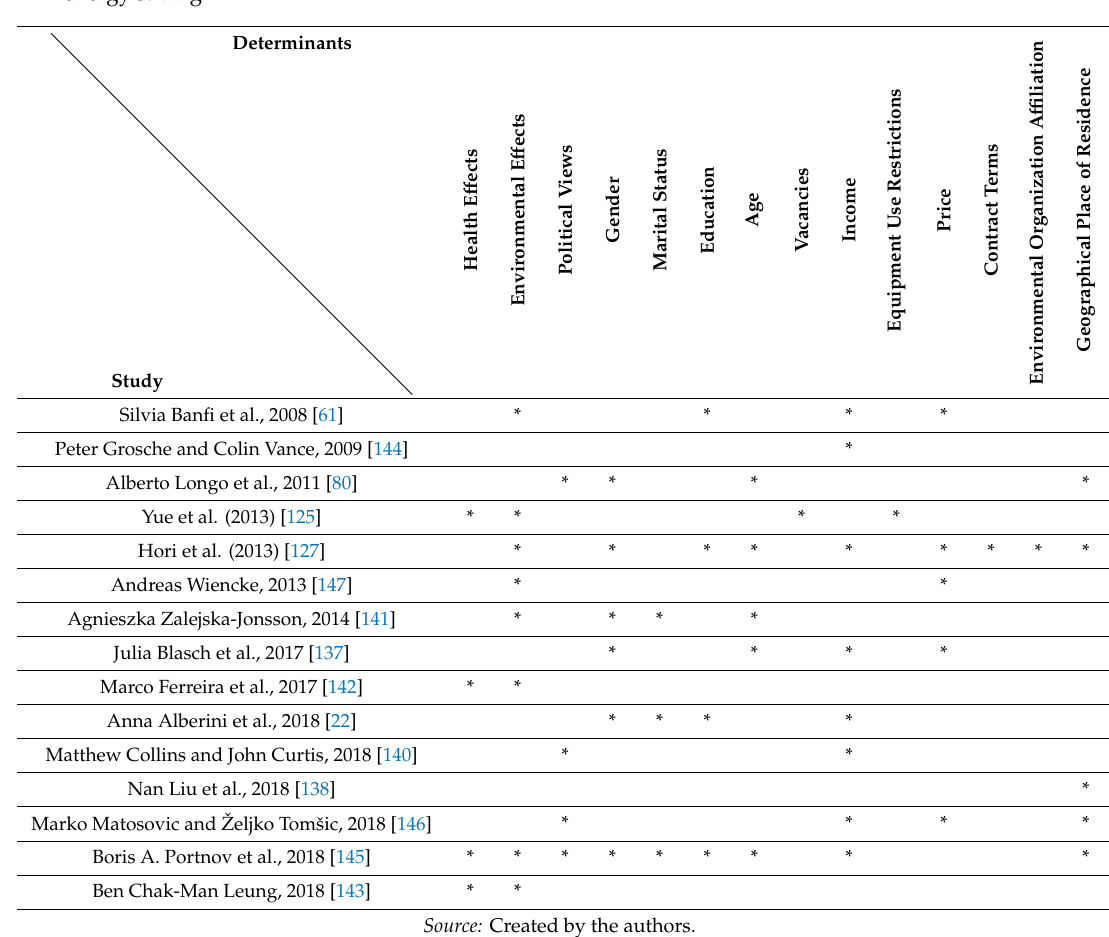
Common determinants or socio-demographic factors a ff ecting households WTP